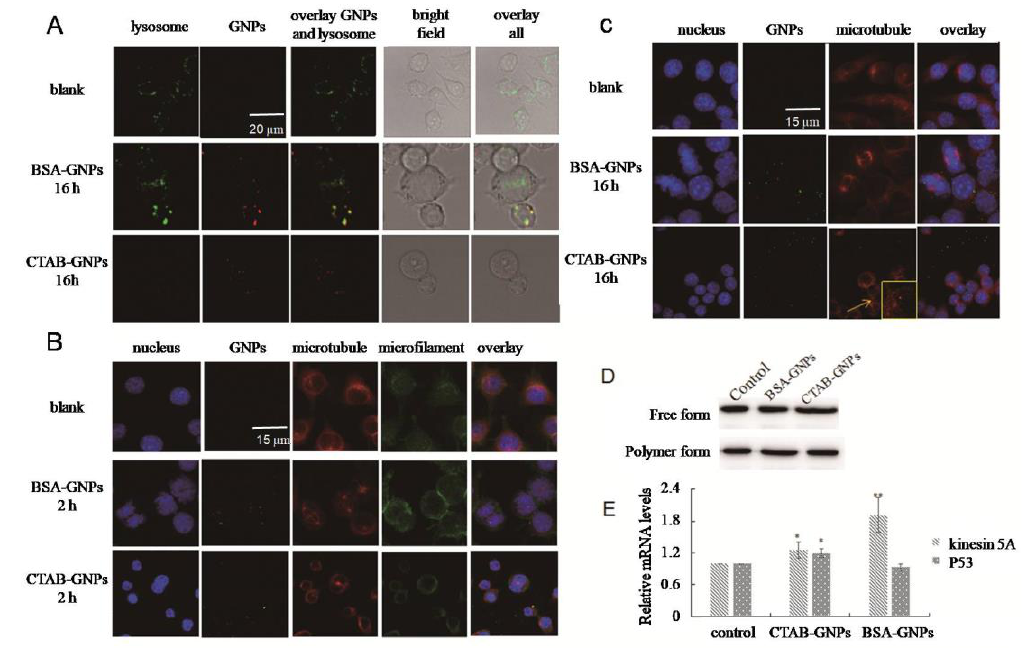
Figure 3. Effect of GNPs on subcellular organelles, with untreated cells used as control. ( A ) Confocal microscopy images of cell lysosome after incubation with GNPs for 16 h, showing colocalization of BSA-GNPs (red) with lysosomes (green). ( B ) Fluorescence microscopy images of cell cytoskeleton after incubation with GNP for 2 h, showing shrinkage of microtubules (red) and microfilaments (green) in CTAB-GNPs and increased microtubules (red) and nuclear (blue) organization in the mitosis phase in BSA-GNPs. ( C ) Fluorescence microscopy images of cell cytoskeleton after incubation with GNP for 16 h, showing colocalization of GNPs (green) with microtubules (red). ( D ) Western blot analysis of free tubulin and polymerized microtubule in cells treated with GNPs. ( E ) Relative mRNA levels of kinesin 5A and P53 in cells treated with GNPs.